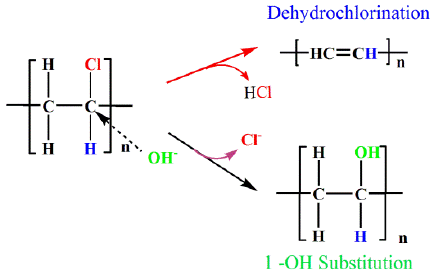
Figure 5. The proposed pathway for chlorine transformation under subcritical water.